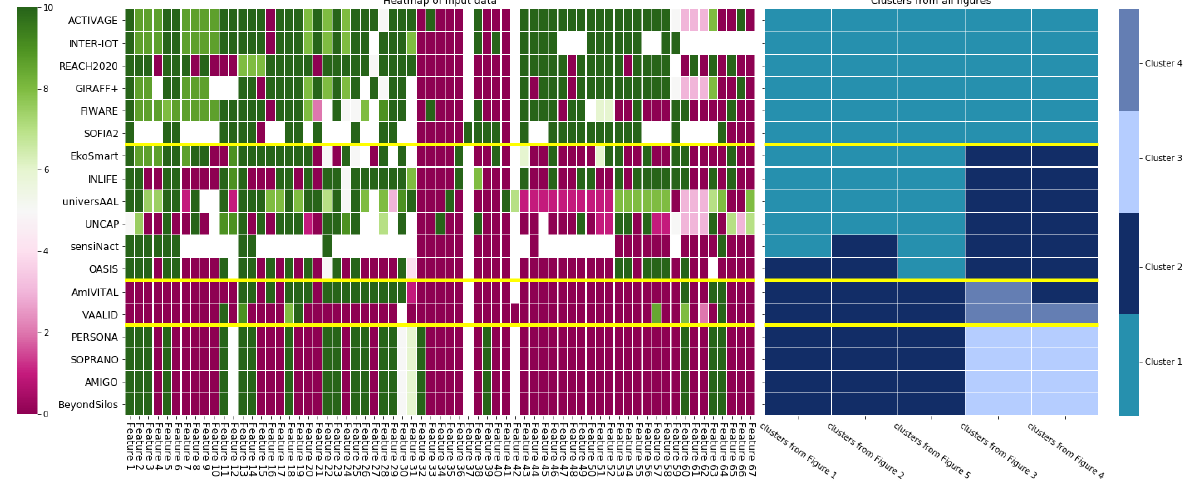
Figure A1. Heat map of input data and heat map of clusters from Figures 1–5.